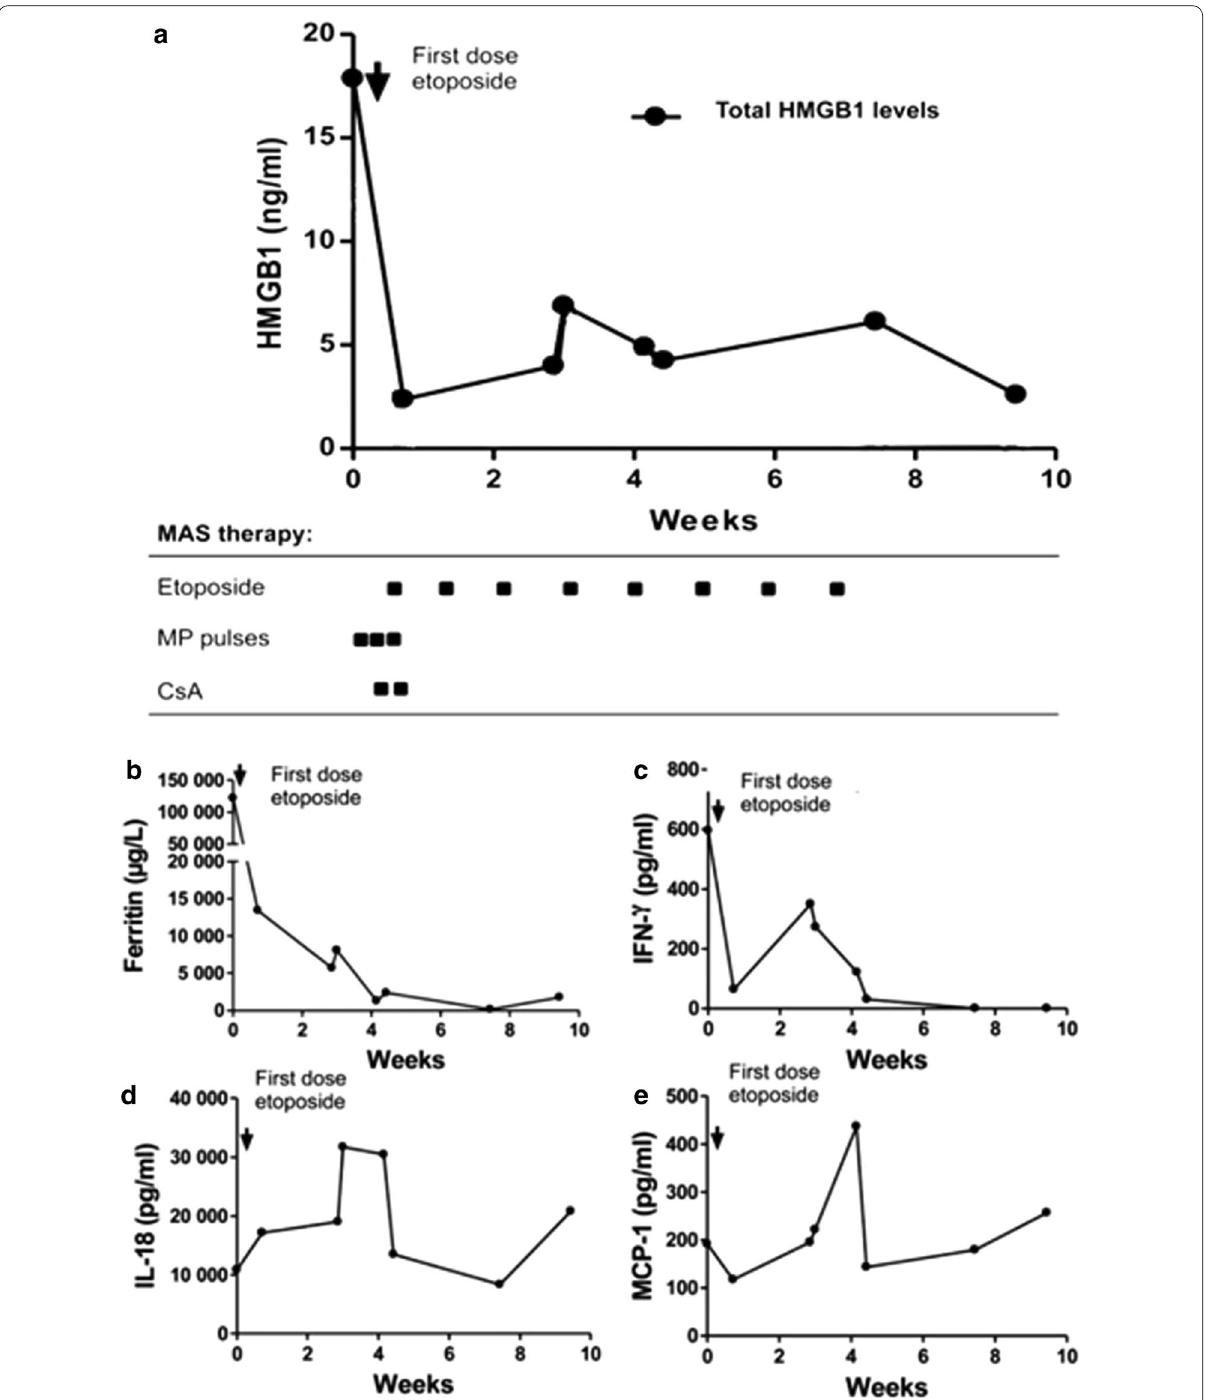
Fig. 4 Longitudinal serum analyses before and after introduction of etoposide treatment in patient #4. The expression of plasma levels of HMGB1 ( a ), and serum levels of ferritin ( b ), IFN‑γ ( c ), and IL‑18 ( d ) corresponded very well to the clinical course of MAS with a rapid decline and clinical improvement after etoposide administration. MCP‑1 levels were increased during the whole study period ( e ). CsA cyclosporine A; MP-pulses methylprednisolone